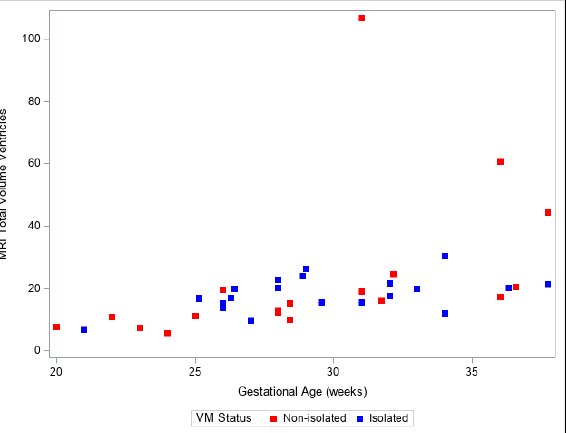
Figure 5. Three-dimensional growth trajectory measurements of ventricle volume in isolated and non-isolated VM.